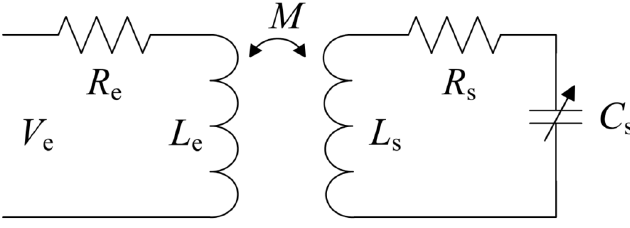
Figure 2. Equivalent circuit of the passive pressure sensor.